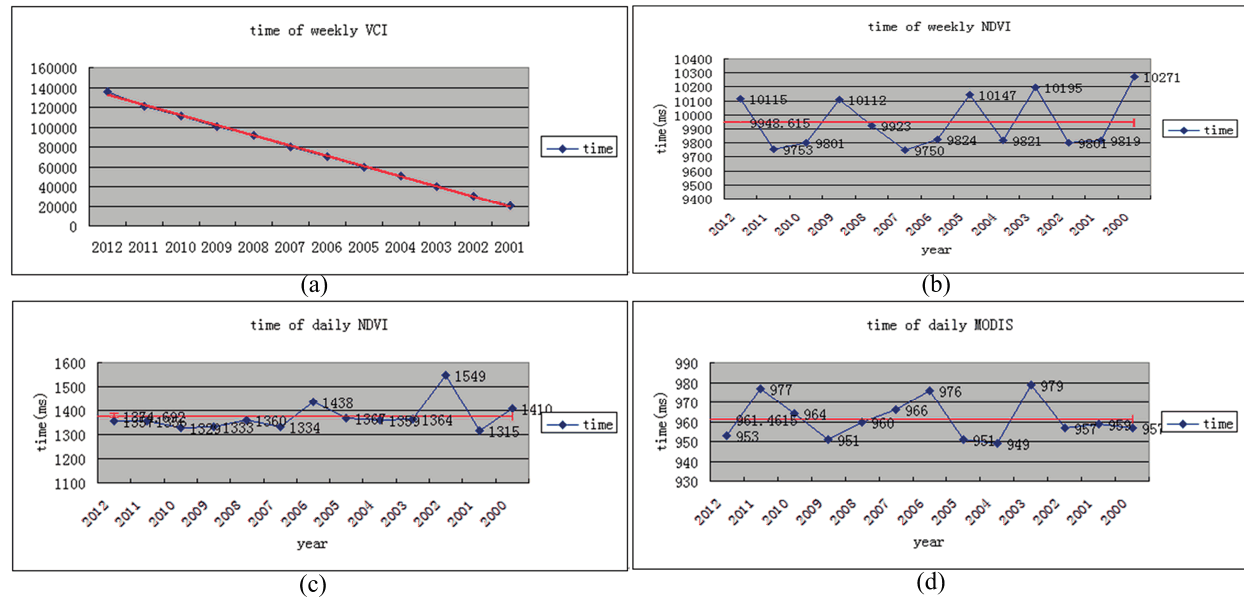
Figure 13. Traversing time of weekly VCI ( a ); weekly NDVI ( b ); daily NDVI ( c ); and daily MODIS ( d